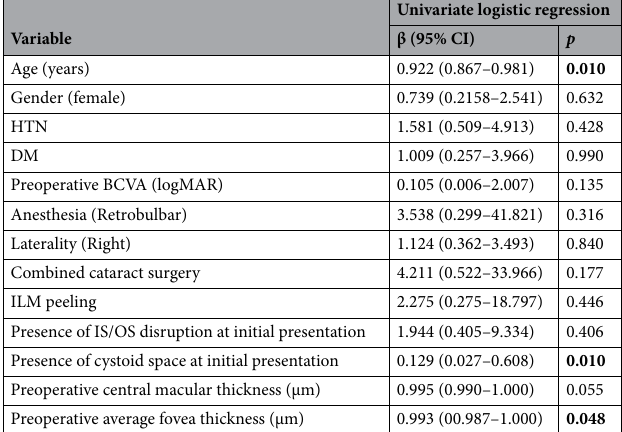
Table 3. Univariate logistic regression analysis of nasal inner nuclear layer thickening in epiretinal membrane patients after surgery. HTN hypertension, DM diabetes mellitus, BCVA best corrected visual acuity, logMAR logarithm of the minimum angle of resolution, ILM internal limiting membrane, IS/OS inner and outer segment. Significant values are in [bold].